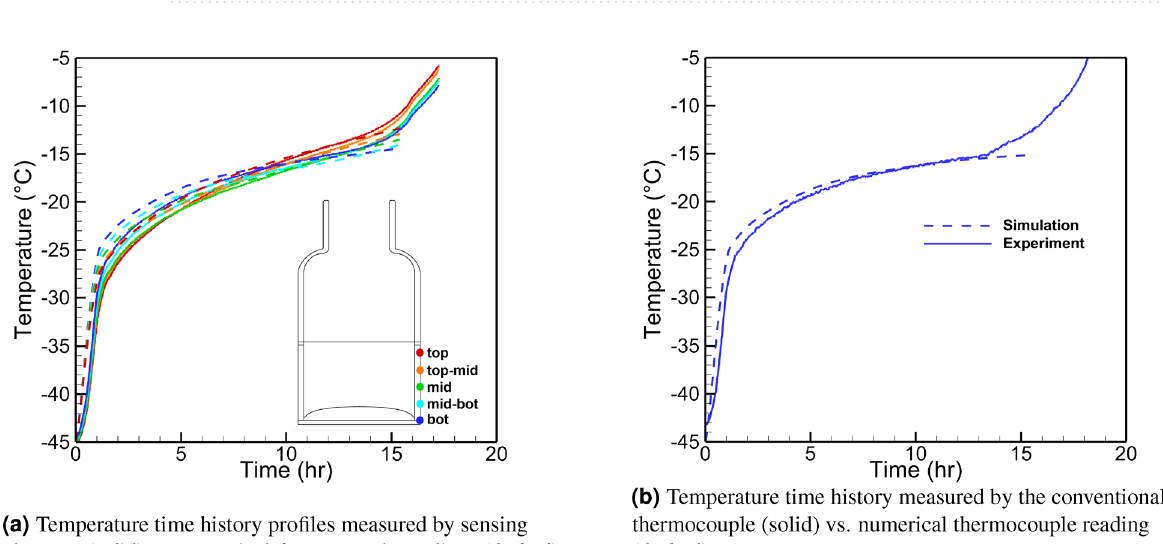
Figure 13. Virtual thermocouple performance evaluation for the central vial #7 (schematic position of the vial is shown in Fig. 8b) during primary drying stage.